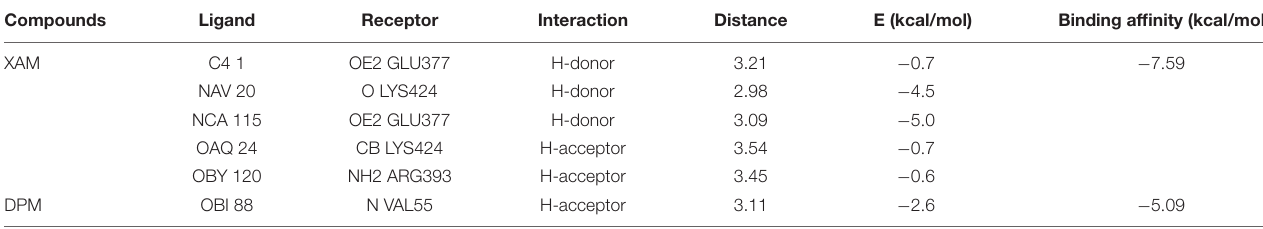
TABLE 6 | Post-docking interactional analysis of XAM and DPM with XylH and CiaH protein. Compounds Ligand Receptor Interaction